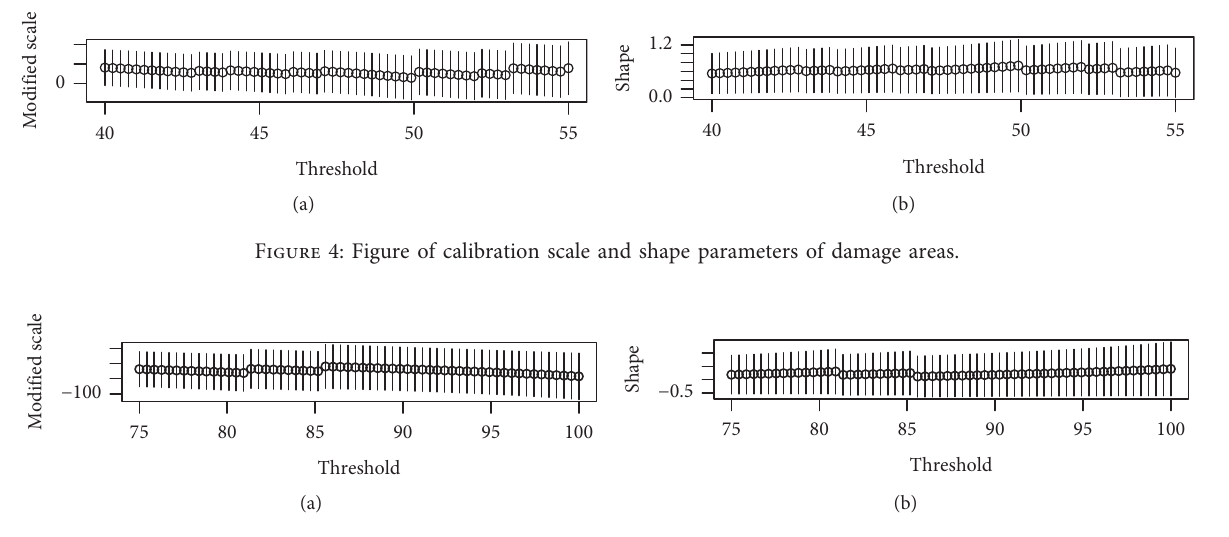
Figure 5: Figure of calibration scale and shape parameters of deaths. Table 1: POT parameters’